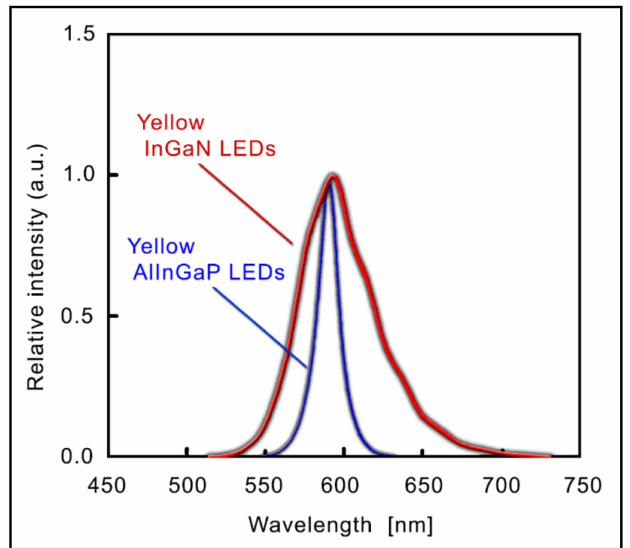
Figure 3. Typical emission spectra of yellow InGaN and yellow